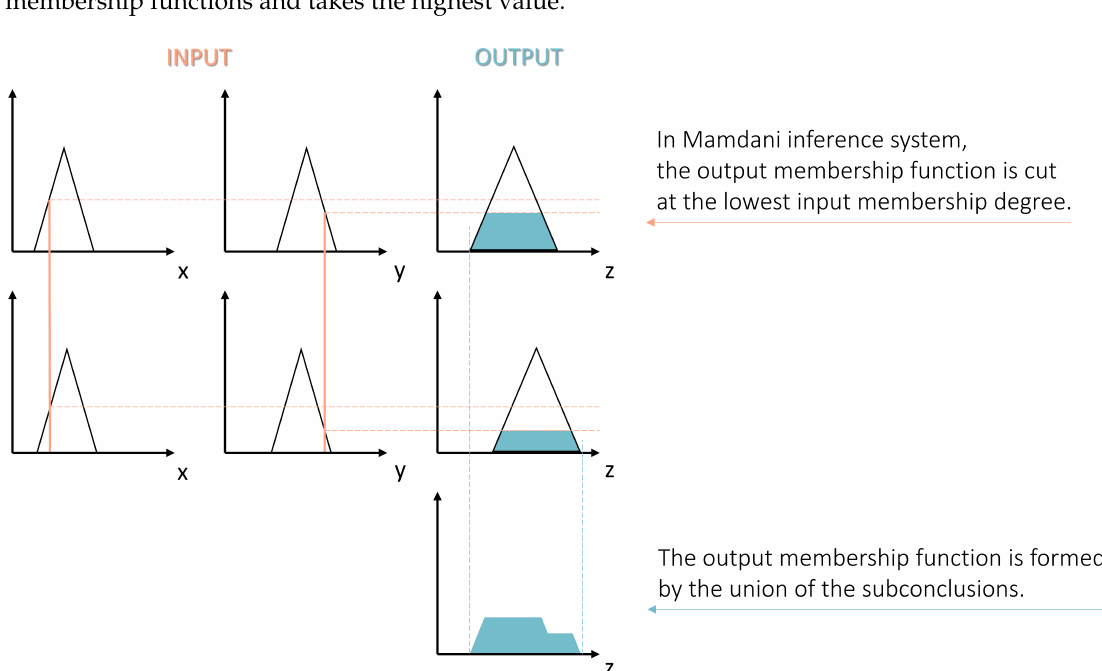
Figure 13. Mamdani inference